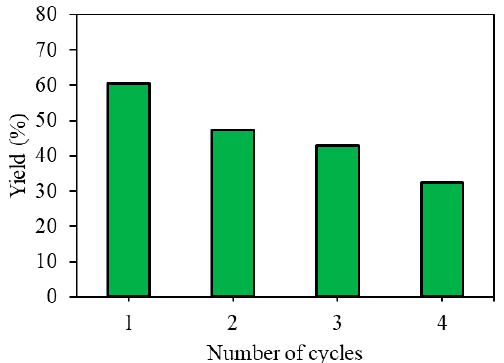
Figure 4. Recycling of the IL Pd-DPEphos catalyst system in the cyclocarbonylation of 2-methyl-3-buten-2-ol to 4,4-dimethyl- γ -butyrolactone. Reaction conditions: 0.1 M 2-methyl-3-buten-2-ol, 4 mol% Pd(OAc) 2 , 16 mol% DPEphos, 1.0 g [BMIM]Cl, 5 mL DCM, 100 °C, 28 bar (CO/H 2 /N 2 : 20/5/3), 18 h.